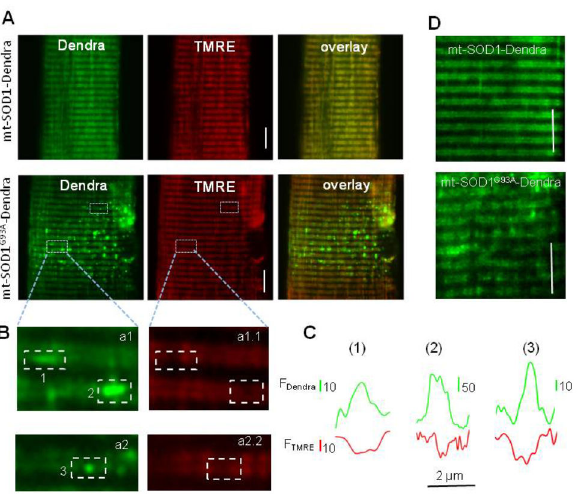
Figure 4. Expression of mitochondria-targeted SOD1 in skeletal muscle of normal mice. ( A ) Normal muscle fibers transfected with mt-SOD1-Dendra or mt-SOD1 G93A -Dendra. Both proteins preferentially target to mitochondria. 90% of fibers expressing mt-SOD1 G93A -Dendra show aggregated fluorescent proteins inside mitochondria (n=73), while not a single fiber expressing wild type mt-SOD1-Dendra has protein Figure 5. Migration of mt-SOD1-Dendra and mt-SOD1 G93A - aggregates (n=36). ( B ) Enlarged boxes ( a1 and a2 ) taken from Dendra in normal muscle fibers. Representative images of the mt-SOD1 G93A -Dendra fiber show that fiber regions (1, 2 and muscle fibers expressing mt-SOD1-Dendra ( A ) or mt- 3) with fluorescent protein aggregates have reduced TMRE SOD1 G93A -Dendra ( B ). Before photoactivation Dendra was a staining ( a1.1 and a2.2 ). ( C ) Fluorescence profiles of Dendra green fluorescent protein (green images in left panels). A small ( F , green) and TMRE ( F , red) at those three regions region of the fiber was photoactivated. The photoactivation Dendra TMRE indicate that depolarized mitochondria are at the site of protein region in the fiber was marked with the box (white dashed line). aggregates. ( D ). Representative images of normal muscle After the photoactivation Dendra was converted to a red fibers expressing mt-SOD1-Dendra or mt-SOD1 G93A -Dendra. fluorescent protein (red images in right planes). ( C ) Migration of 63% of mt-SOD1 G93A -Dendra fibers show fragmented mt-SOD1-Dendra in the presence of 200 nM FCCP. Bar: 10 mitochondria comparing to only 11% of mt-SOD1-Dendra µm. ( D ) The migration time course of the red fluorescent fibers. Bar: 10 µm. protein. Solid lines are the linear regression of the data after 2 minutes of the photoactivation. Dashed lines are the linear regression of the data in the first 2 minutes, assuming the migration step is zero at time zero. The migration rates are listed in Table 1 .